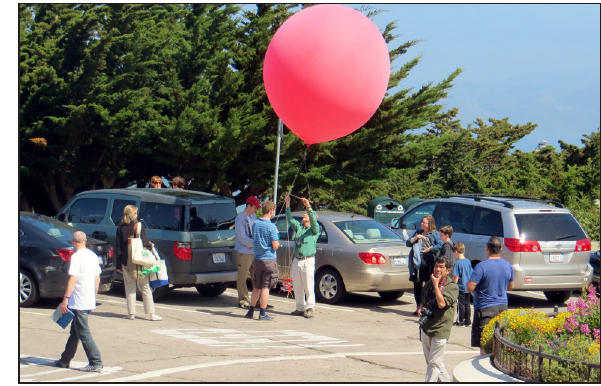
Figure 4: Many citizen science project designers hope not only to collect important scientific information but also to help project participants gain skills such as scientific reasoning. Here, a team of volunteers with Public Lab, a non-profit environmental science community, launch a weather balloon. Data collected via the balloon will be used in 3-D mapping surveys, but figuring out how to measure just what participants are learning as they conduct this research is a challenge for the citizen science